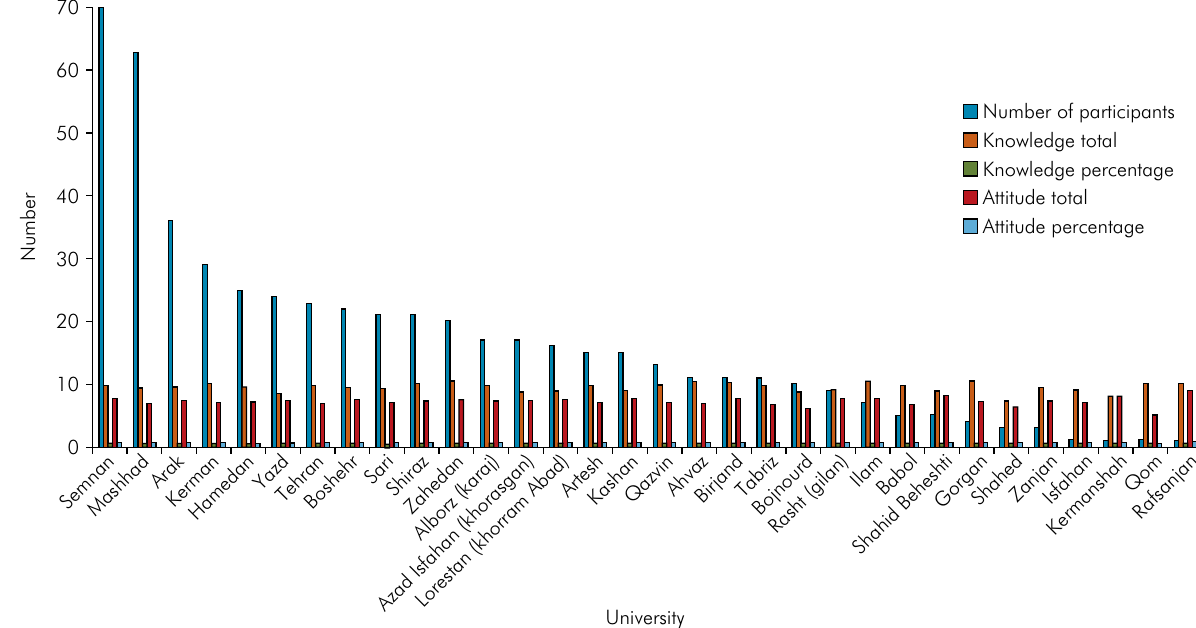
Figure 2. The distribution of students’ cooperation, level of knowledge, and attitude according to the educational institution (university).